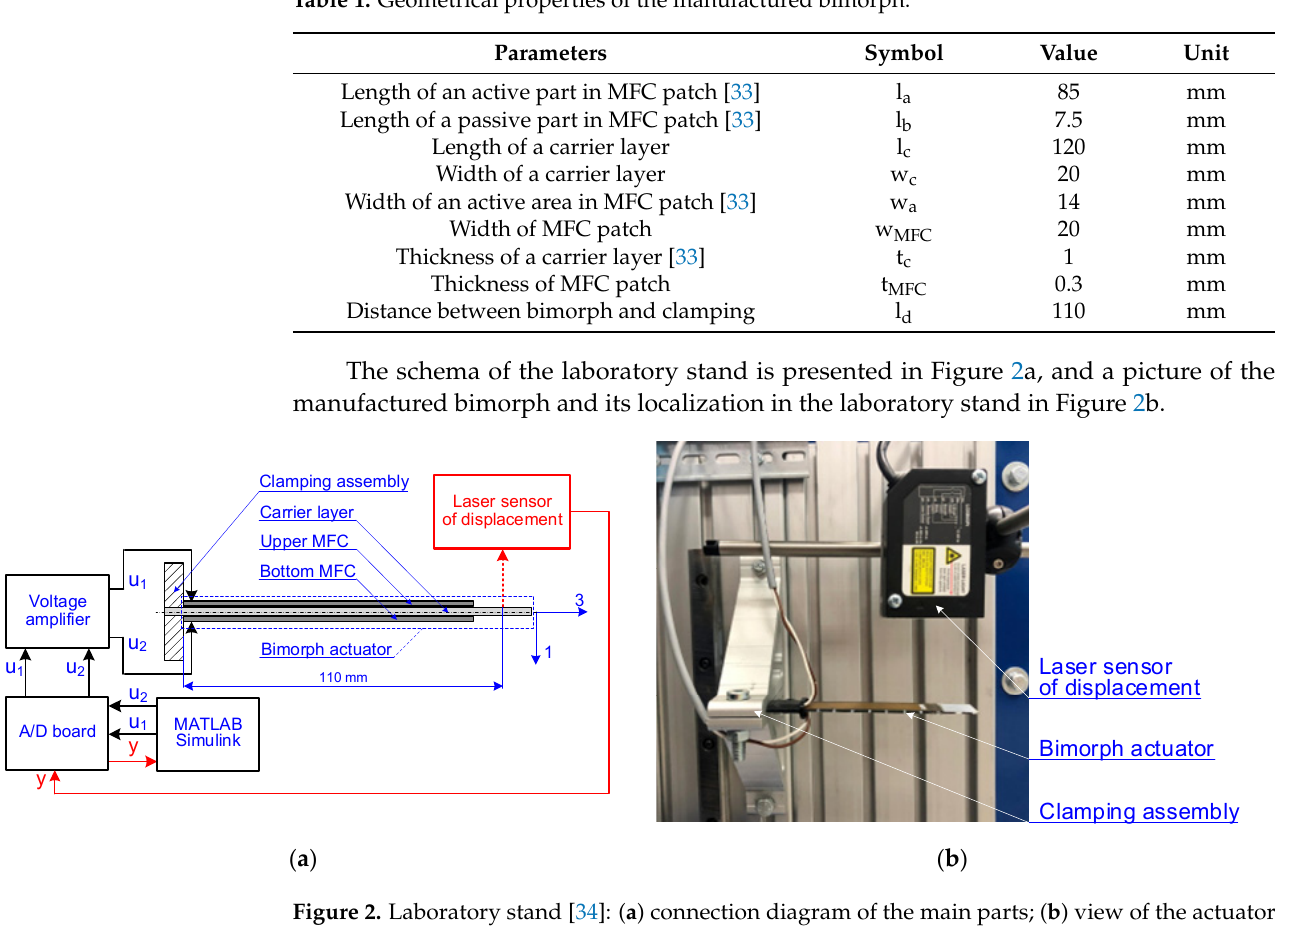
Table 1. Geometrical properties of the manufactured bimorph.